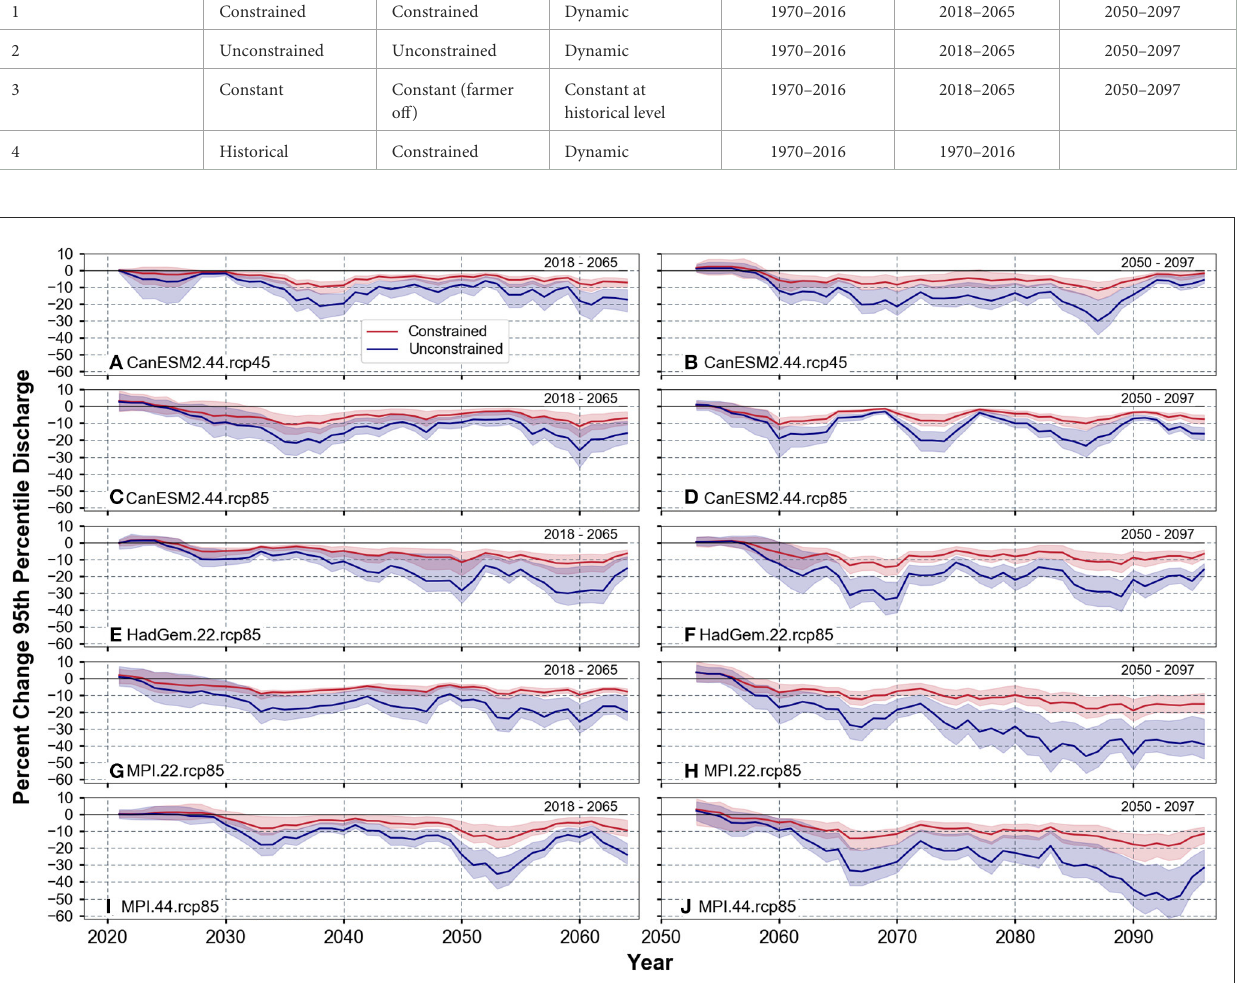
0.06 to a mean ConsMax parameter of 0.067–0.09, depending